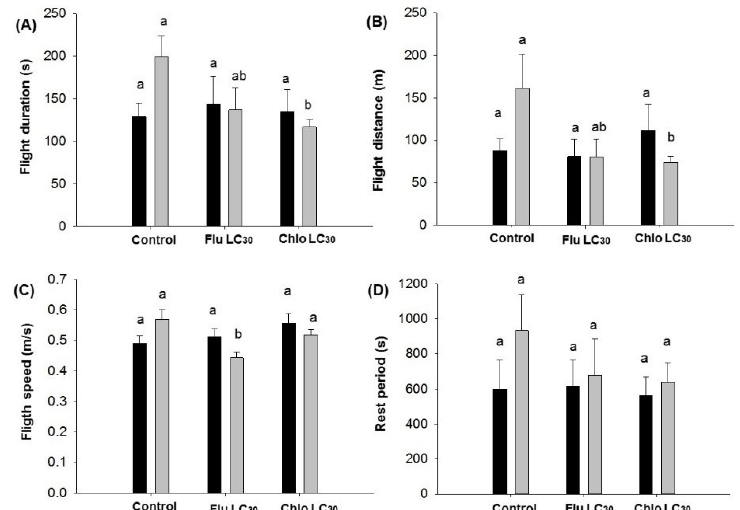
Figure 4. Chloridea virescens unsustained flights less than 30 min: ( A ) Mean flight duration, ( B ) mean flight distance, ( C ) mean flight speed, and ( D ) mean rest period. Black bars represent female and grey bars represent male moths. Di ff erent letters above the standard error bars indicate significant di ff erences based on Tukey–Kramer test ( p < 0.05).